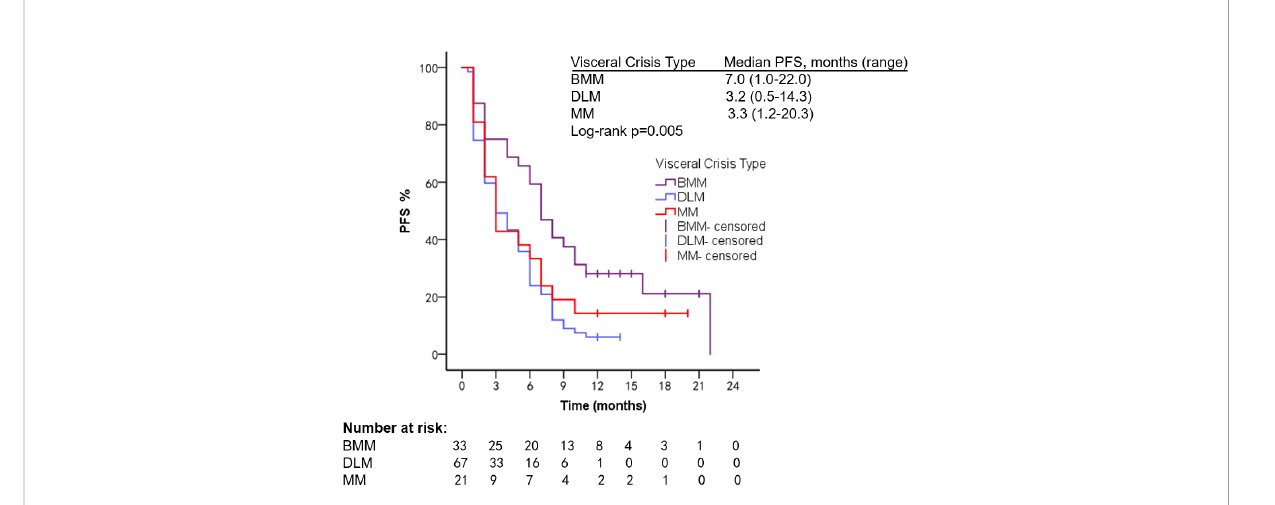
FIGURE 5 PFS of HR+, Her-2 − patients after using different treatment